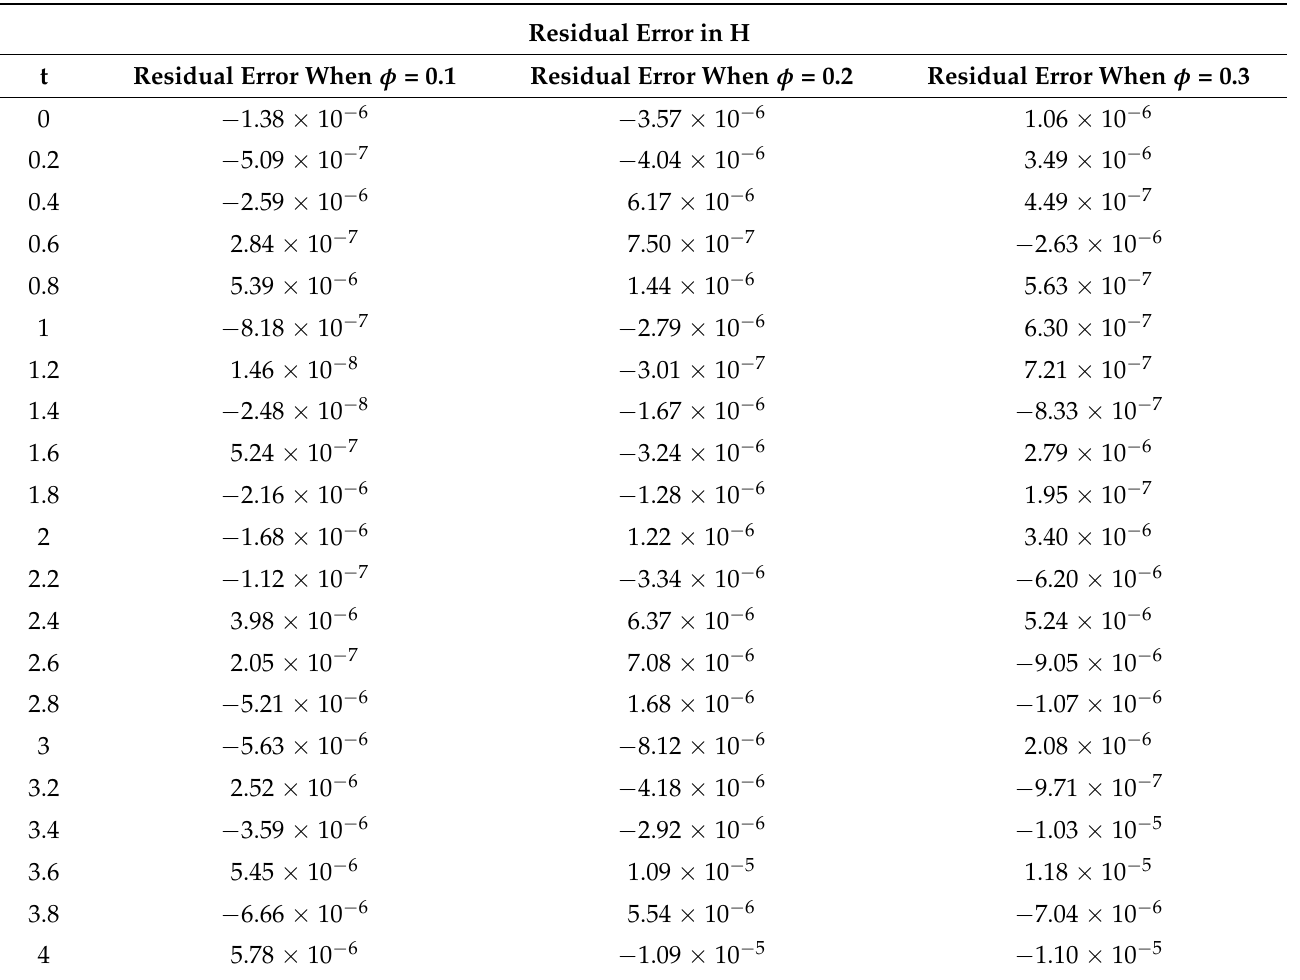
Table 16. The residual error between RK4 and LMBNN in the outputs of H.